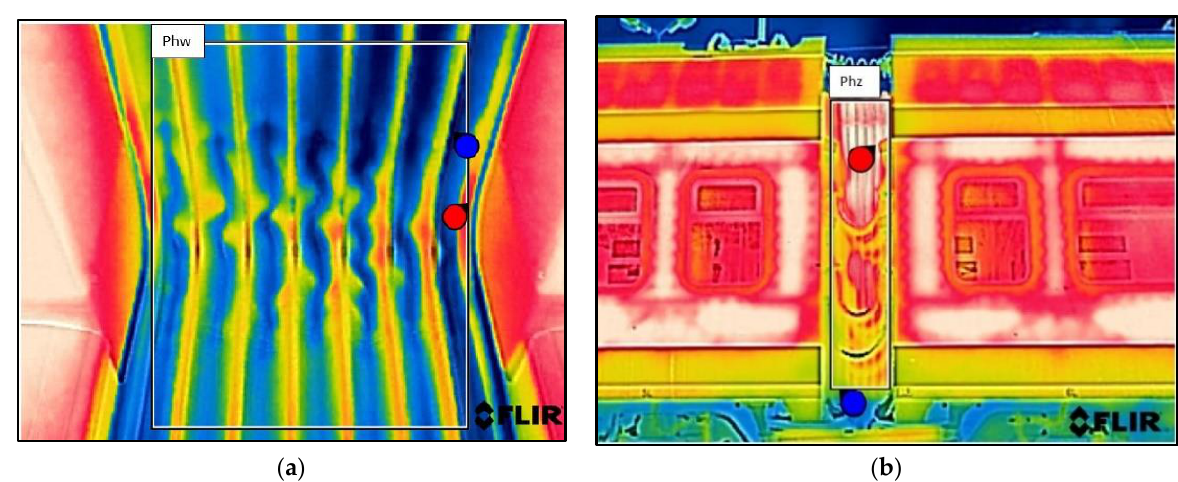
Figure 9. Defined locations for calculating the average door temperature value: ( a ) the upper part from inside the vehicle — Dwg1, Dwg2, Dwg3; ( b ) the lower part from inside the vehicle — Dwd1, Dwd2, Dwd3; ( c ) the upper and lower parts on the outside of the vehicle — Dz1, Dz2, Dz3. where: — the red dots indicate the locations with the highest recorded temperature; — the blue dots indicate the locations with the lowest recorded temperature.